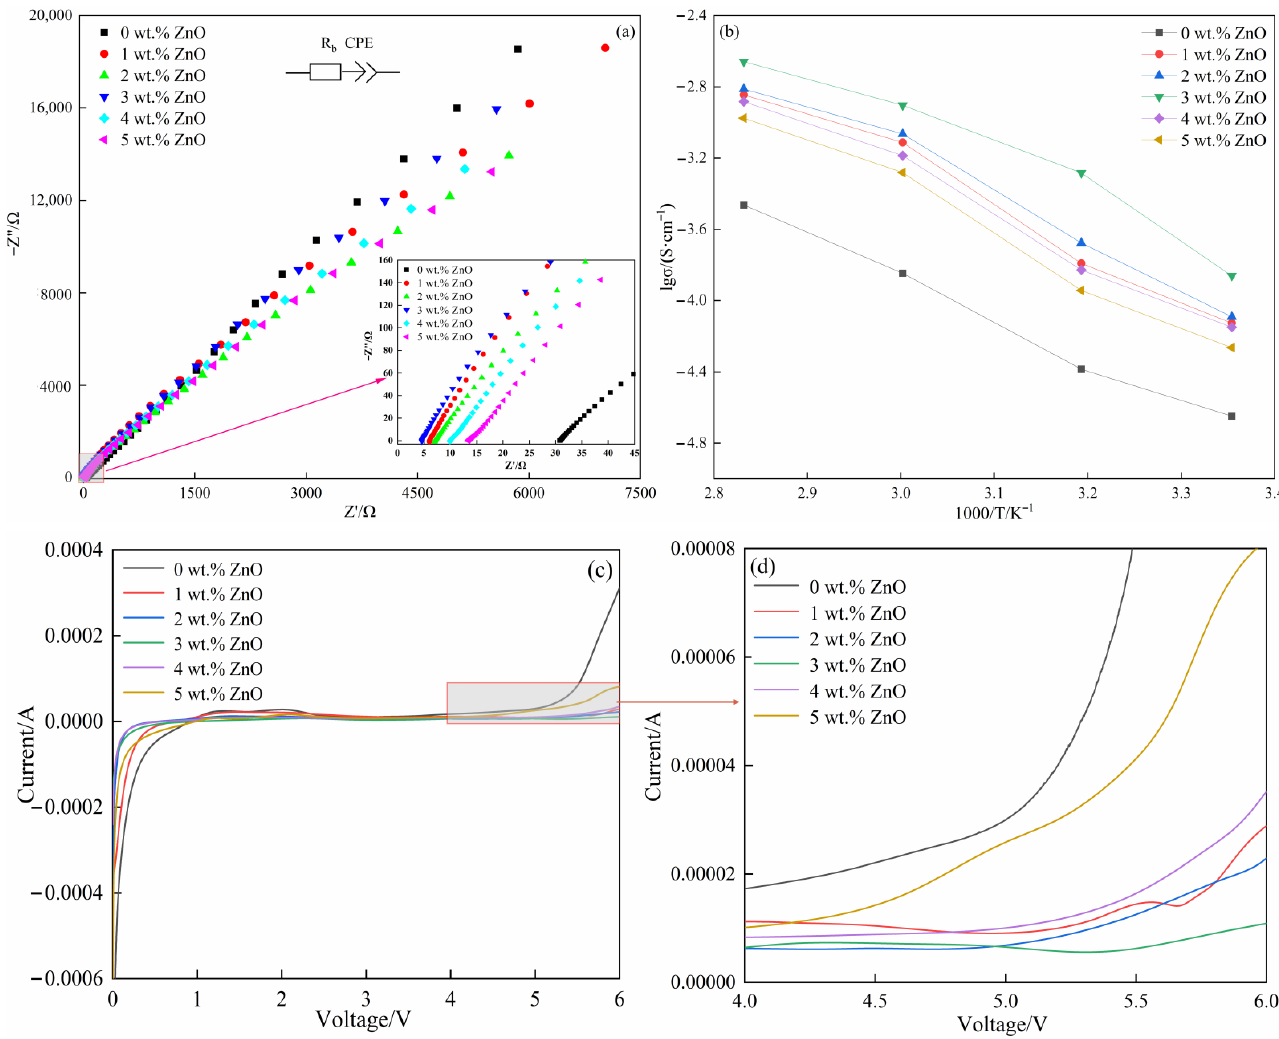
Figure 4. EIS and the local magnification (inset) of the SPEs (0 wt.% ZnO [26], 1–5 wt.% ZnO) in the symmetrical coin cells (SS (stainless-steel sheet)/SPE/SS) at 60 °C ( a ); Arrhenius plots of the SPEs (0 wt.% ZnO [26], 1–5 wt.% ZnO) in the symmetrical coin cells (SS/SPE/SS) at 20 °C, 40 °C, 60 °C, and 80 °C ( b ); and electrochemical windows ( c ) of the SPEs (0 wt.% ZnO [26], 1–5 wt.% ZnO), and the local magnification ( d ) of the SPEs (0 wt.% ZnO [26], 1–5 wt.% ZnO) in the asymmetrical coin cells (Li (lithium sheet)/SPE/SS) at 60 °C.